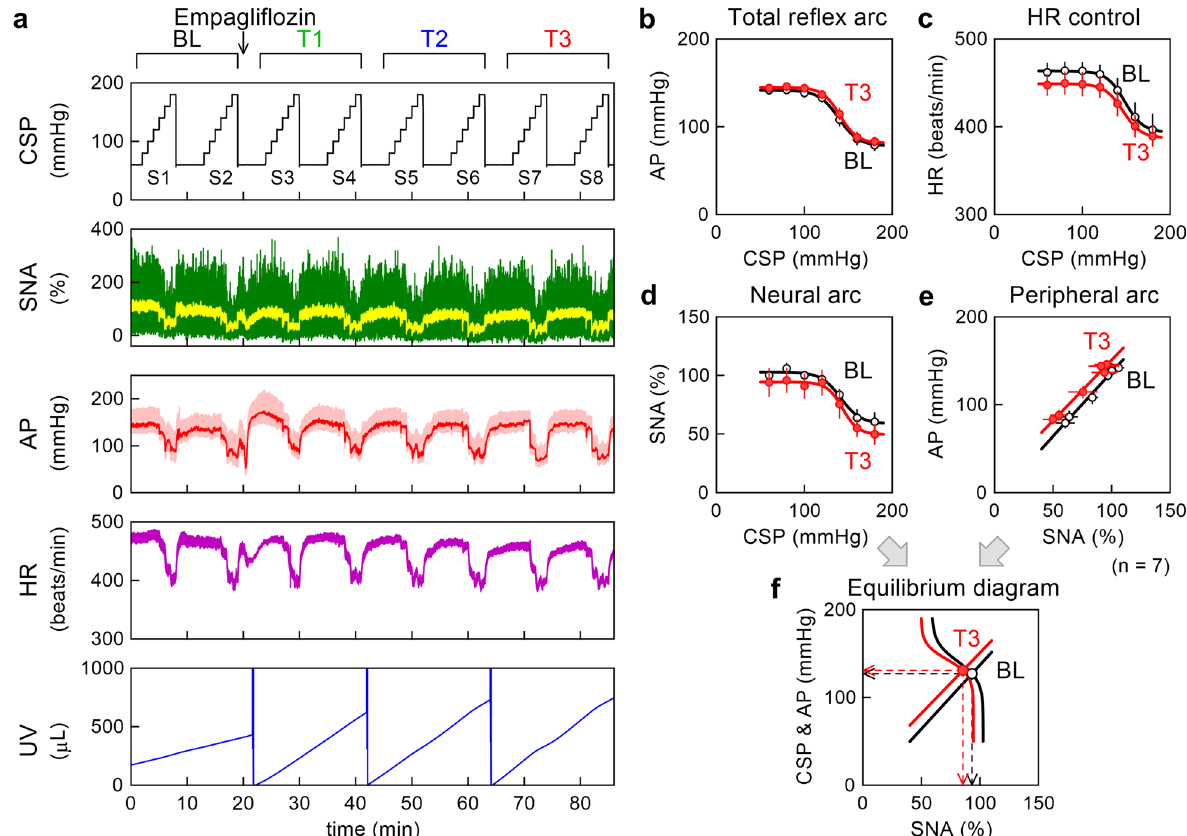
Fig. 2 a An example time series obtained from a Goto–Kakizaki rat in the empagliflozin group. Carotid sinus pressure (CSP), sympathetic nerve activity (SNA), arterial pressure (AP), heart rate (HR), and urine volume (UV) during stepwise input sequences (S1–S8) are shown. In the CSP, HR, and UV plots, the data illustrate 10-Hz resampled signals. In the SNA plot, 10-Hz resampled (green) and 2-s moving averaged (yellow) signals are shown. In the AP plot, 100-Hz resampled (pale red) and 2-s moving averaged (red) signals are shown. In the UV plot, sharp reductions with vertical artifacts indicate manual urine removals. The data were divided into baseline (BL), T1, T2, and T3 periods of two input sequences each. Empagliflozin (10 mg kg − 1 ) was administered one minute after the completion of S2. b – e Pooled data showing the total reflex arc, HR control, neural arc, and peripheral arc. The black lines with open circles represent the data obtained during BL. The red lines with filled circles represent the data obtained during T3. The data points represent mean SE values (n 7 rats). f Baroreflex equilibrium diagrams derived from fitted neural and peripheral arcs. ± = The black open circle and the red filled circle indicate the operating points during BL and T3, respectively. The leftward arrowheads indicate the AP values at the operating points. The downward arrowheads indicate the SNA values at the operating